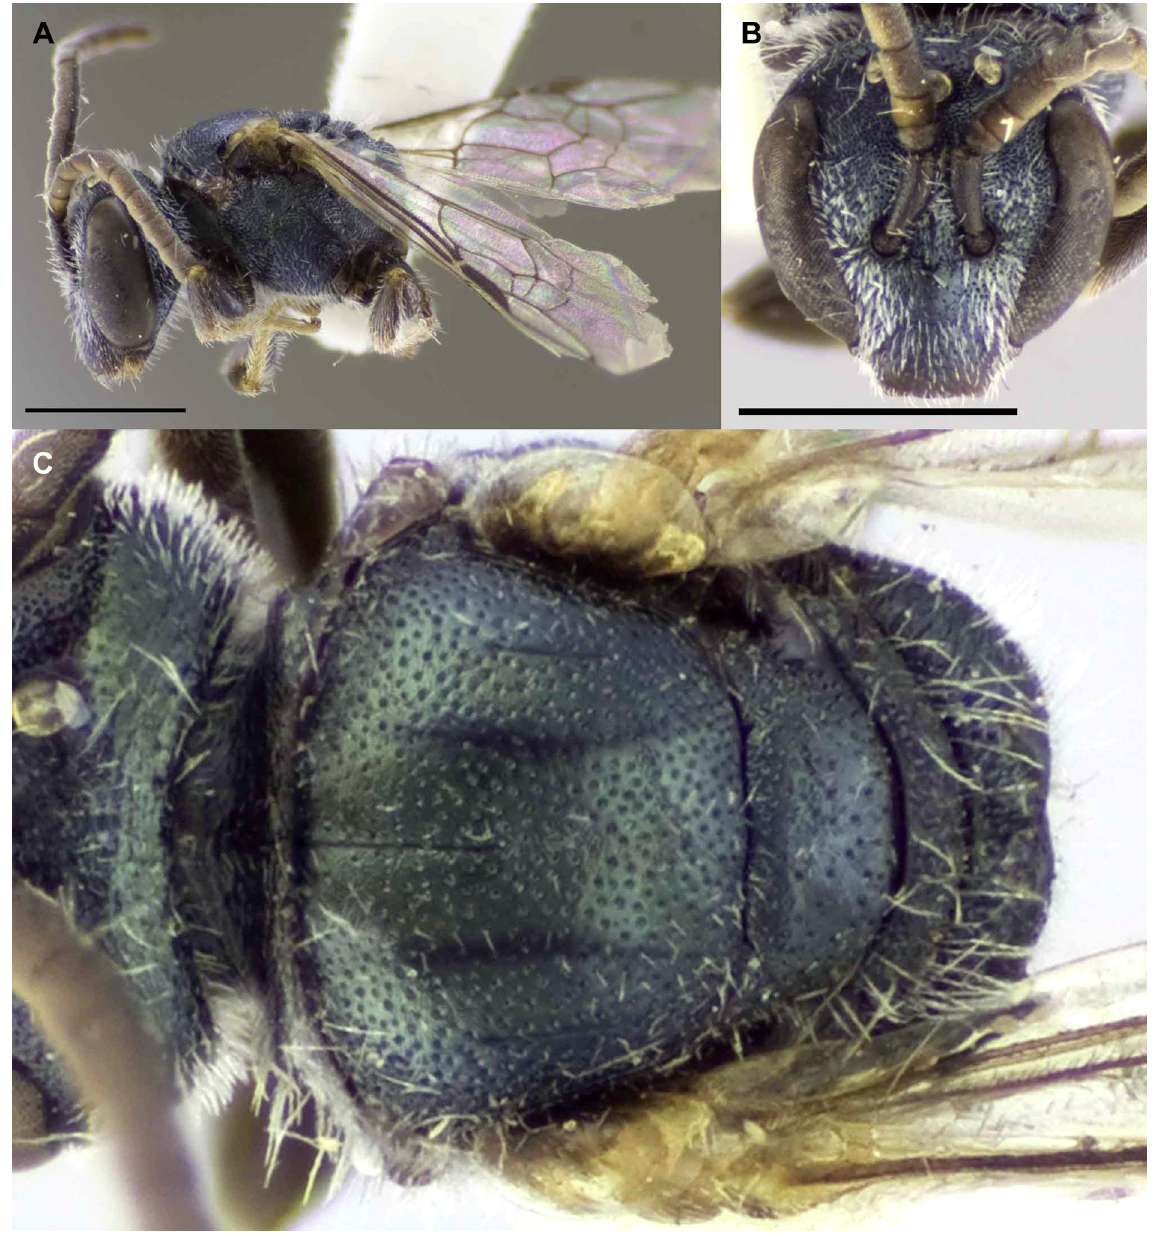
Fig. 68. Lasioglossum ( D .) surianae (Mitchell, 1960), ♂ (reproduced from Gibbs 2011) (UCFC). A . Lateral habitus. B . Face. C . Mesonotum. Scale bars = 1